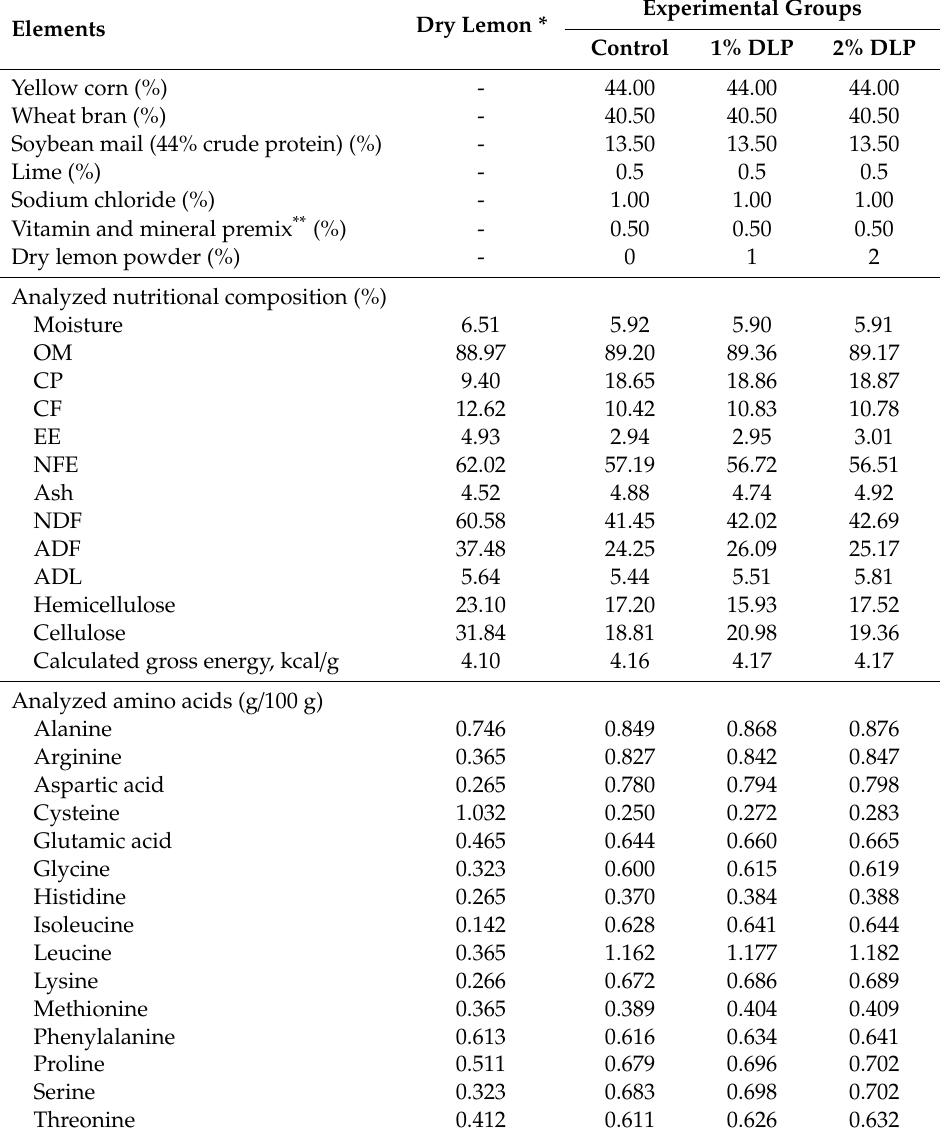
Table 1. Ingredients, amino acids and nutritional analysis of rations and dry